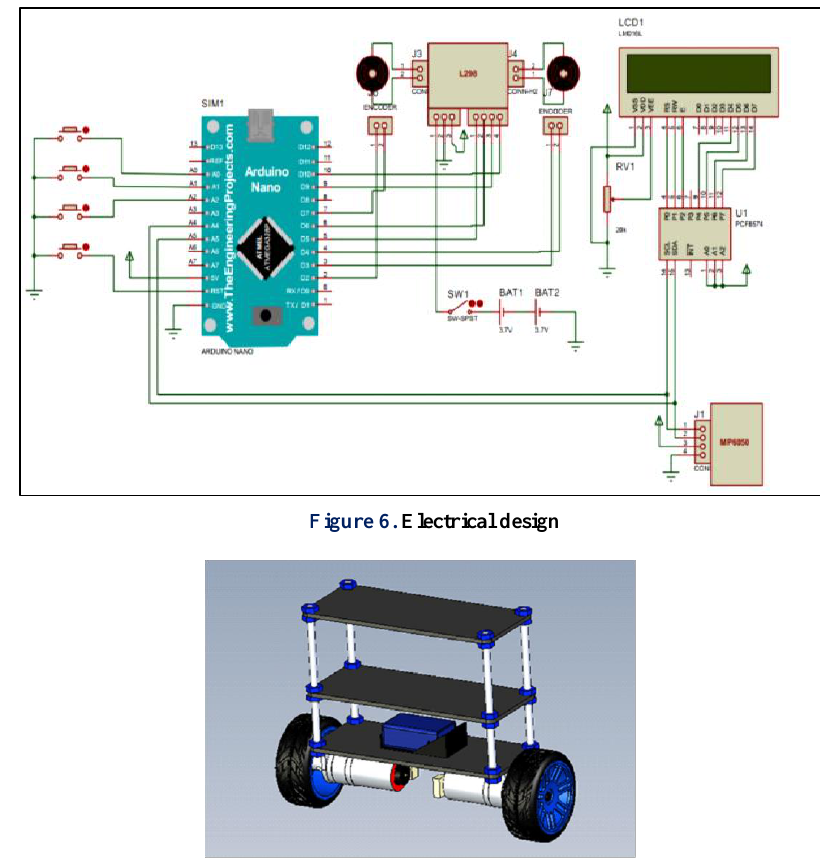
Figure 7. Self-balancing robot prototype design